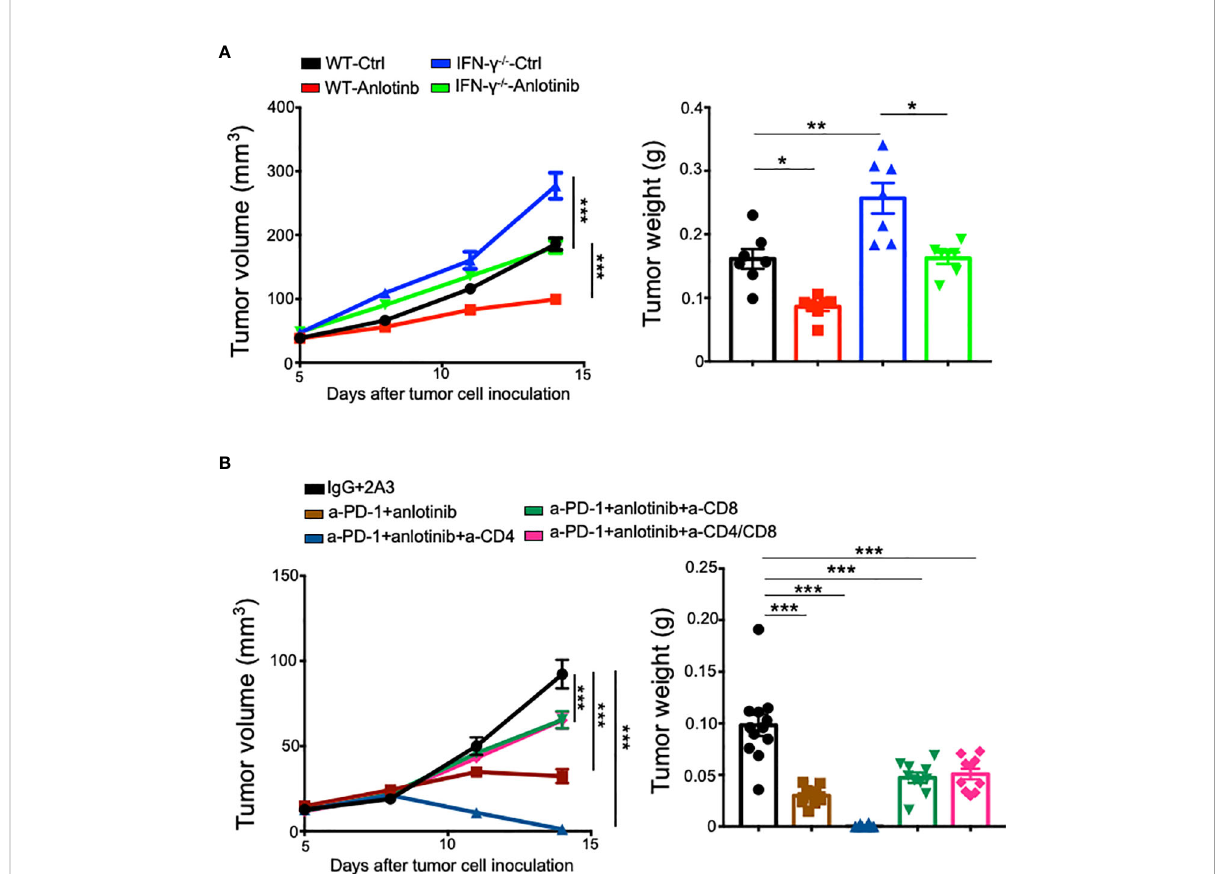
FIGURE 7 In vivo depletion of CD8 + T cells partially reversed the antitumor effects of the combination therapy, while Anlotinib treatments inhibited tumor growth independent of IFN- g . WT or IFN- g − / − mice were orthotopically inoculated with 2 × 10 5 EO771 breast tumor cells. When EO771 breast tumors reached 3 – 4 mm in diameter, mice were randomly divided into appropriate groups and treated with ddH 2 O or Anlotinib (2 mg/kg/daily), IgG, or anti-PD-1 antibodies (5 mg/kg every 3 days). Some groups of mice were also treated with isotype 2A3, anti-CD8, or/and anti-CD4 antibodies (200 µg/mouse) on days 5, 7, and 12 after tumor cell inoculation. (A) The impacts of IFN- g on tumor growth upon Anlotinib treatments. (B) The in fl uences of T-cell depletion on tumor growth upon Anlotinib and anti-PD-1 combination therapy. The signi fi cance was determined by one-way ANOVA ( n = 7 mice per group in A, and n = 10 – 12 mice per group in B ). The data are presented as means±SEM. * p < 0.05; ** p < 0.01; *** p <